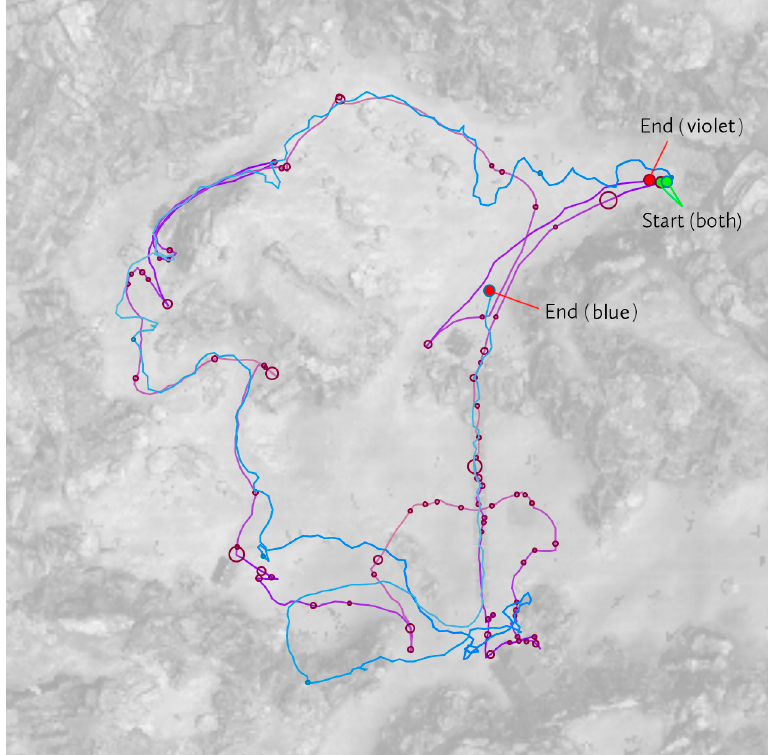
Figure 5. The participant indicated by the blue line walked through the environment with few pauses along their virtual trajectory (path) in a rather jagged fashion (side-stepping left/right, using the keyboard interface frequently). This contrasted with the participant indicated by the violet line, who moved at a slower exploration pace primarily in a forward direction and paused more often (visualized as circles of varying size, larger circles indicating a longer pause).